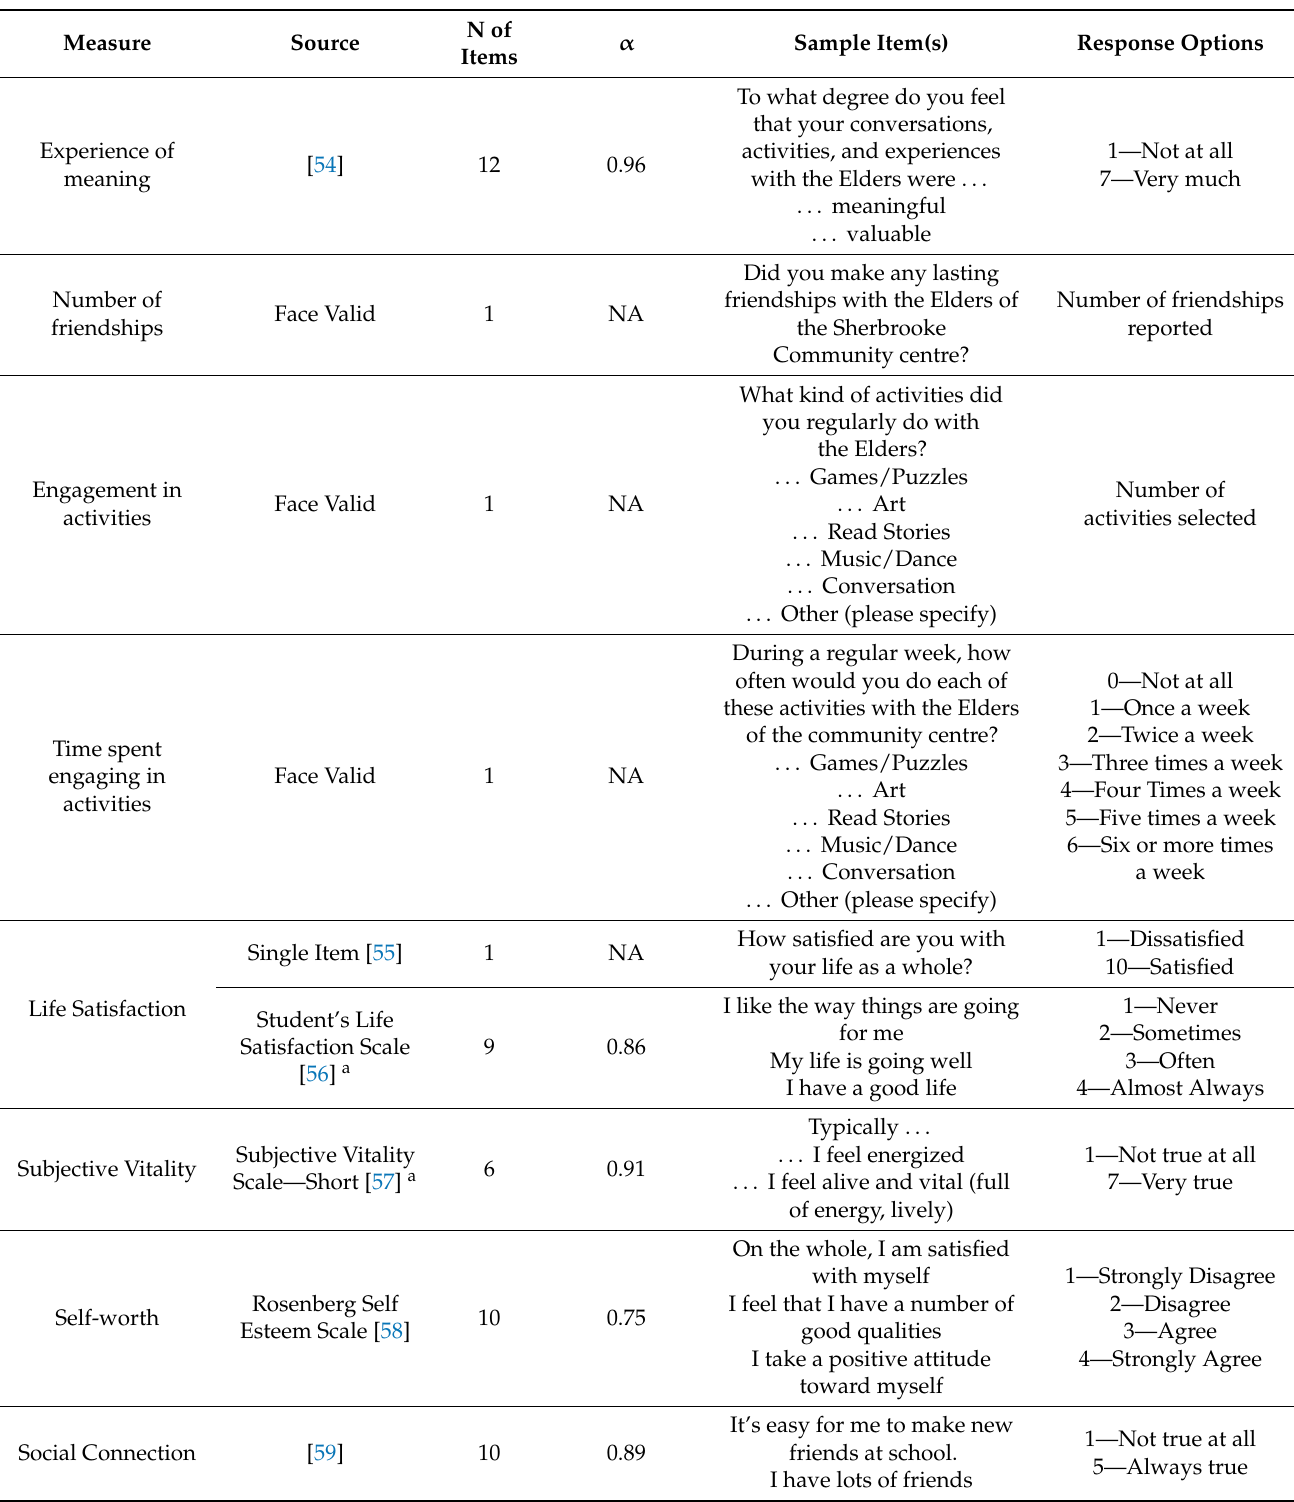
Table 1. Summary of measures (Study